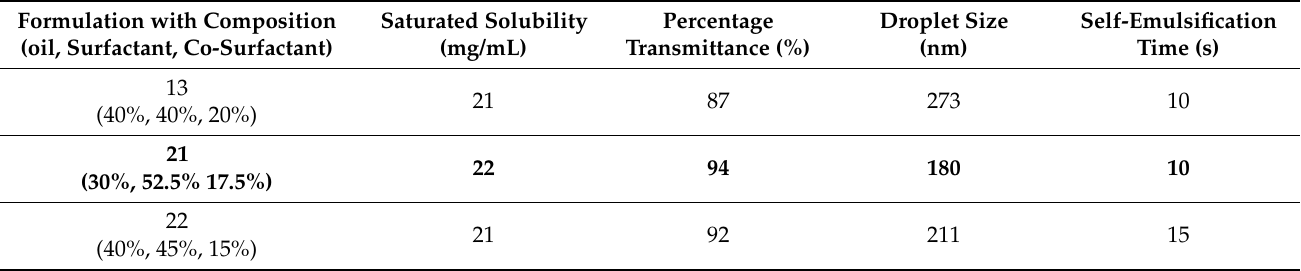
Table 2. Physicochemical characterization of selected formulations. The results are shown as mean ±